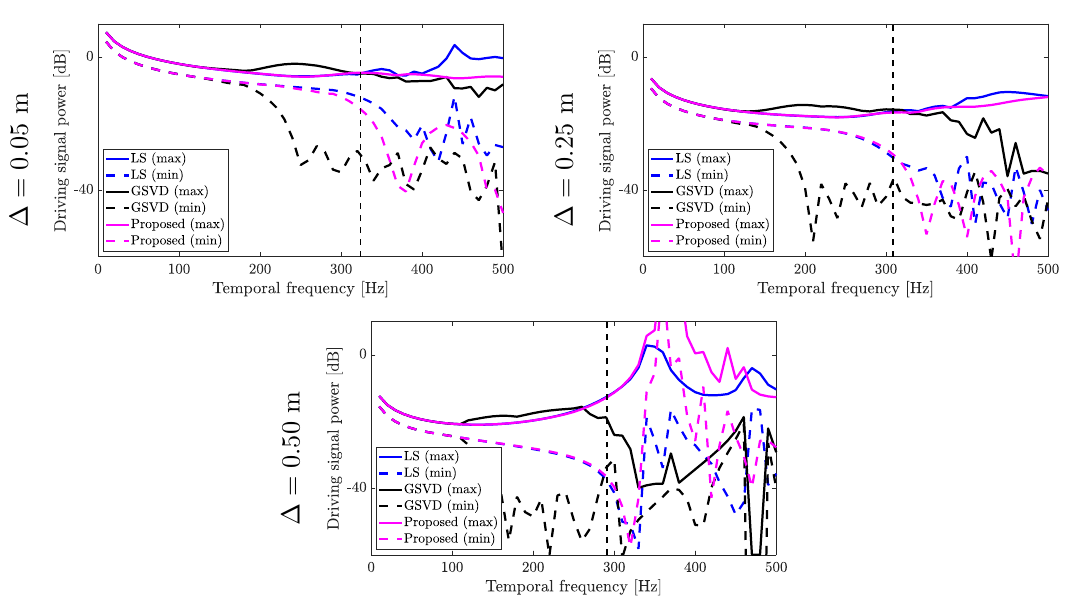
Figure 10. Results of maximum and minimum driving signal